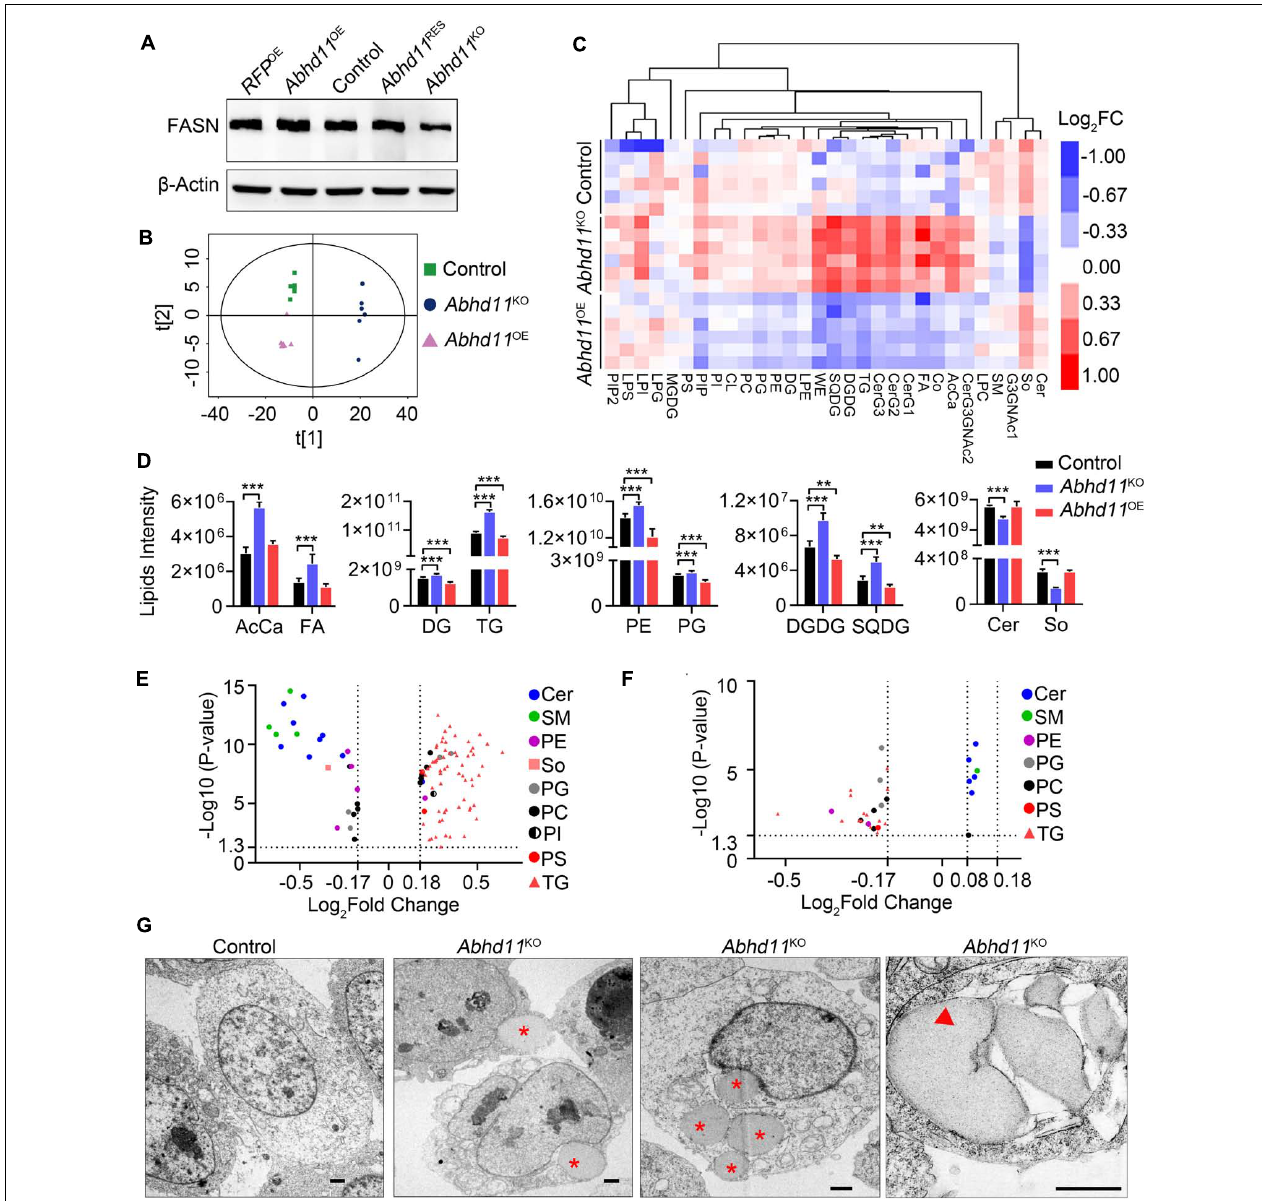
FIGURE 8 | ABHD11 contributes to the homeostasis of lipid metabolism. (A) Western blot analysis of FASN expression level in the indicated cells. (B) Principal component analysis of lipid metabolites in control, Abhd11 KO , and Abhd11 OE ESCs. (C) Heatmap of the 30 lipid classes content in control, Abhd11 KO , and Abhd11 OE ESCs. AcCa, Acyl Carnitine; Cer, Ceramides; CL, Cardiolipin; Co, Coenzyme; DG, diglyceride; DGDG, Digalactosyldiacylglycerol; FA, Fatty acid; LPC, lysophosphatidylcholine; LPE, lysophosphatidylethanolamine; LPG, lysophosphatidylglycerol; LPI, lysophosphatidylinositol; MGDG, Monogalactosyldiacylglycerol; So, Sphingosine; SM, sphingomyelin; PC, phosphatidylcholine; PE, phosphatidylethanolamine; PG,phosphatidylglycerol; PI, phosphatidylinositol; PIP, phosphatidylinositol; PS, phosphatidylserine; TG, triglyceride; SQDG, Sulfoquinovosyldiacylglycerol; WE, wax exters. (D) Lipid intensity of lipid classes altered in Abhd11 KO and Abhd11 OE ESCs measured by LC-MS/MS. Data were represented as mean ± s.d. from six biologically independent samples. ** p < 0.01, *** p < 0.001. (E) Volcano plot of lipid species that showed the most significant change in Abhd11 KO ESCs compared to control (fold change (FC) > 1.5 or FC < 0.67, P -value < 0.05, VIP > 1). (F) Volcano plot of lipid species that showed the most significant change in Abhd11 OE ESCs compared to control (FC > 1.2 or FC < 0.67, P -value < 0.05, VIP > 1). (G) Representative TEM images of LD (indicated by a red asterisk) and lipophagosome, which appeared as double-membrane structure and contained LDs (indicated by a red triangle), in Abhd11 KO ESCs. Scale bar, 1 µ